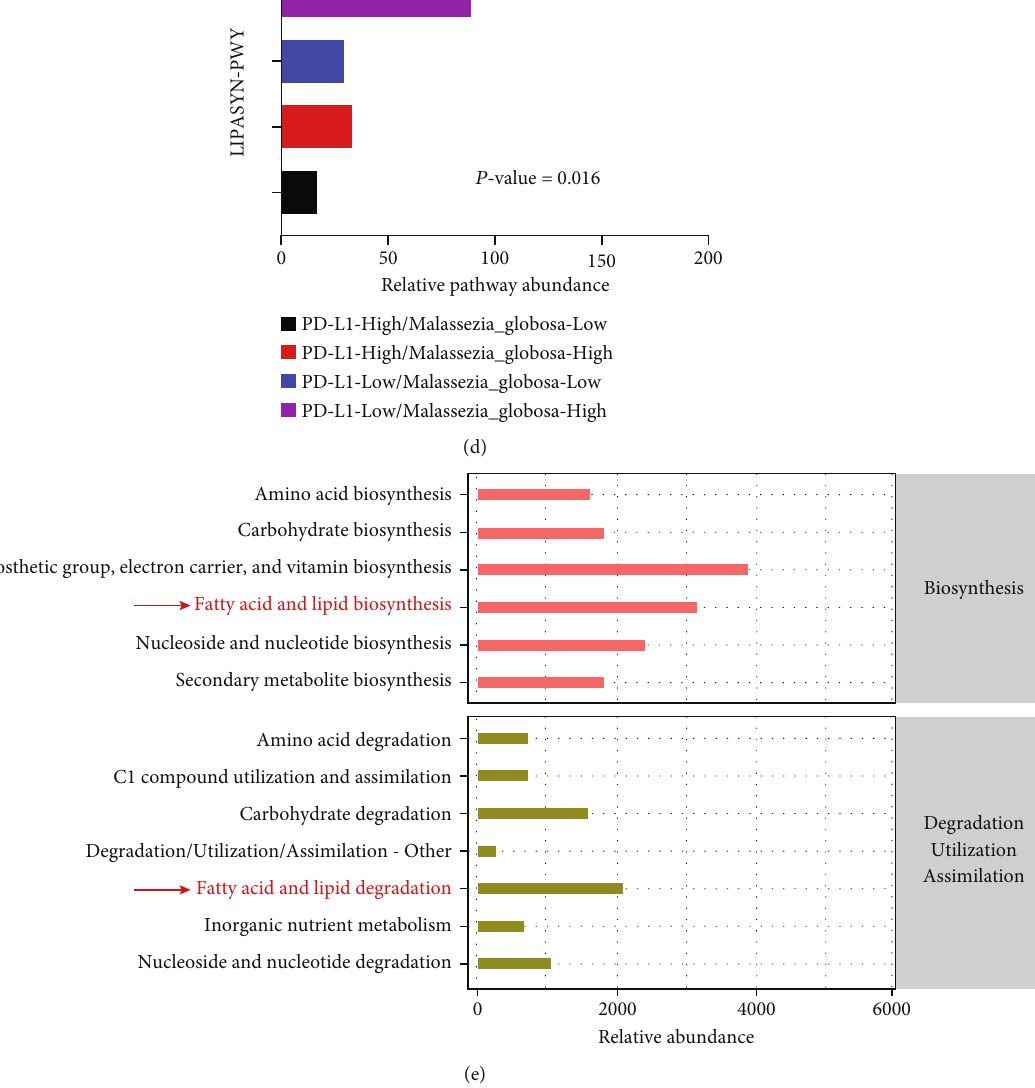
Figure 4: Prediction of pathway related to Malassezia globosa and PD-L1 expression. (a) The enrichment of metabolic pathways between the PD-L1-High and PD-L1-Low group. (b) The association between PD-L1 expression and LIPASYN pathway. (c) The association between Malassezia globosa and LIPASYN pathway. (d) The enrichment of LIPASYN pathway in the di ff erent subgroups of Malassezia globosa and PD-L1 expression. (e) The metabolism-related processes were